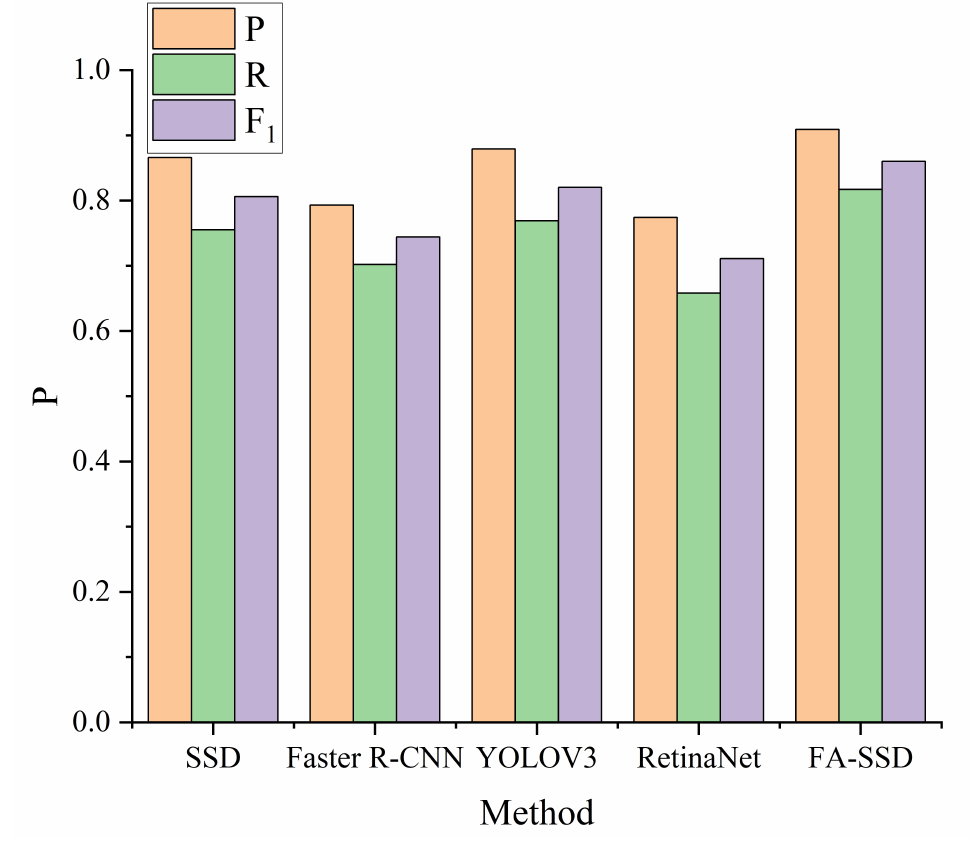
Figure 9. Results of different